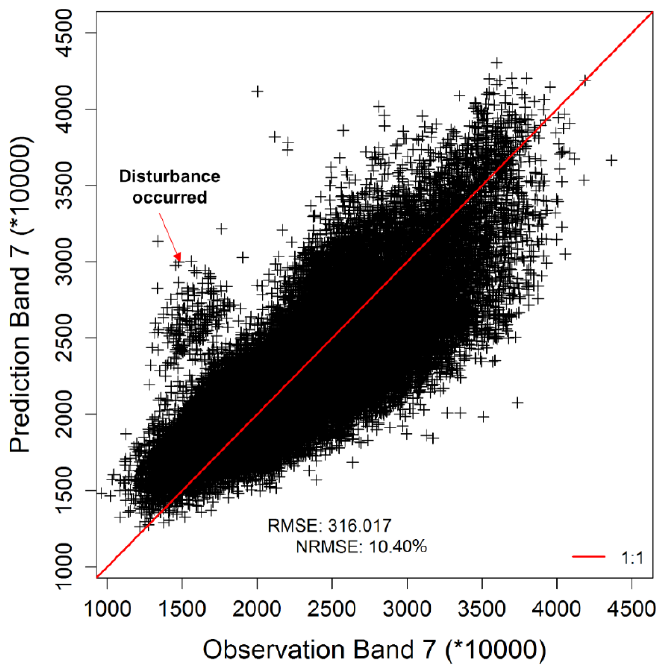
Figure 8. Observation and prediction plot of band 7 based on linear relationship between ln(band 7) and CET 00.5